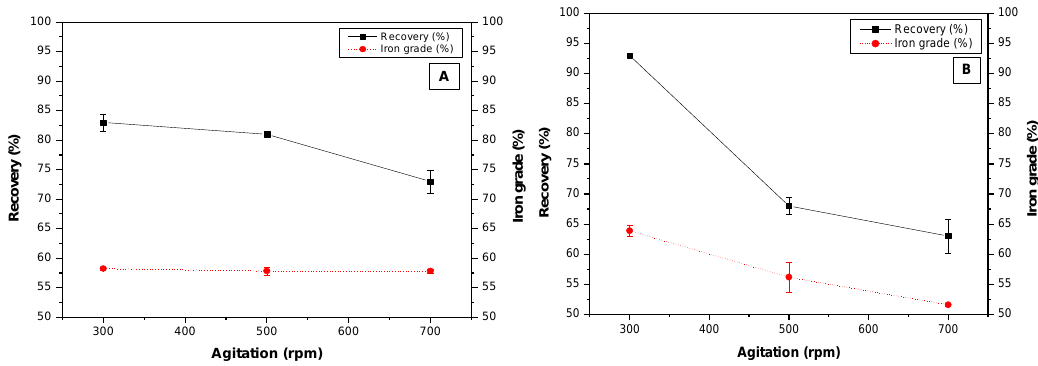
Figure 12 . Effect of system agitation on iron ore electroflotation. Current density 16 mA/cm 2 , (biosurfactant): 300 mg/L, pH 3. ( A ): Particle size − 38 + 20 µm. ( B ): Particle size − 20 µm.